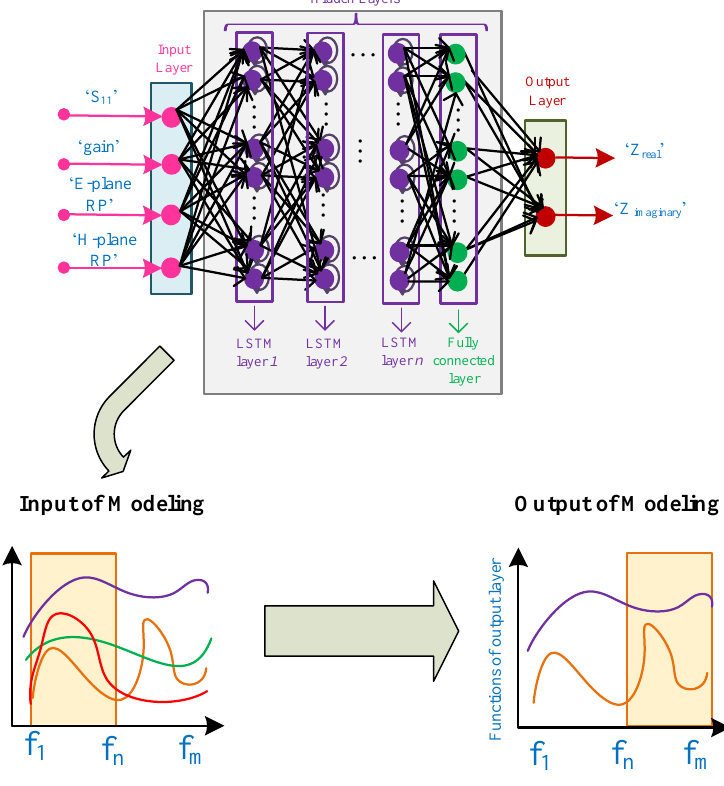
Figure 3. LSTM-based DNN for modeling the antenna and predicting the extended impedances in the frequency